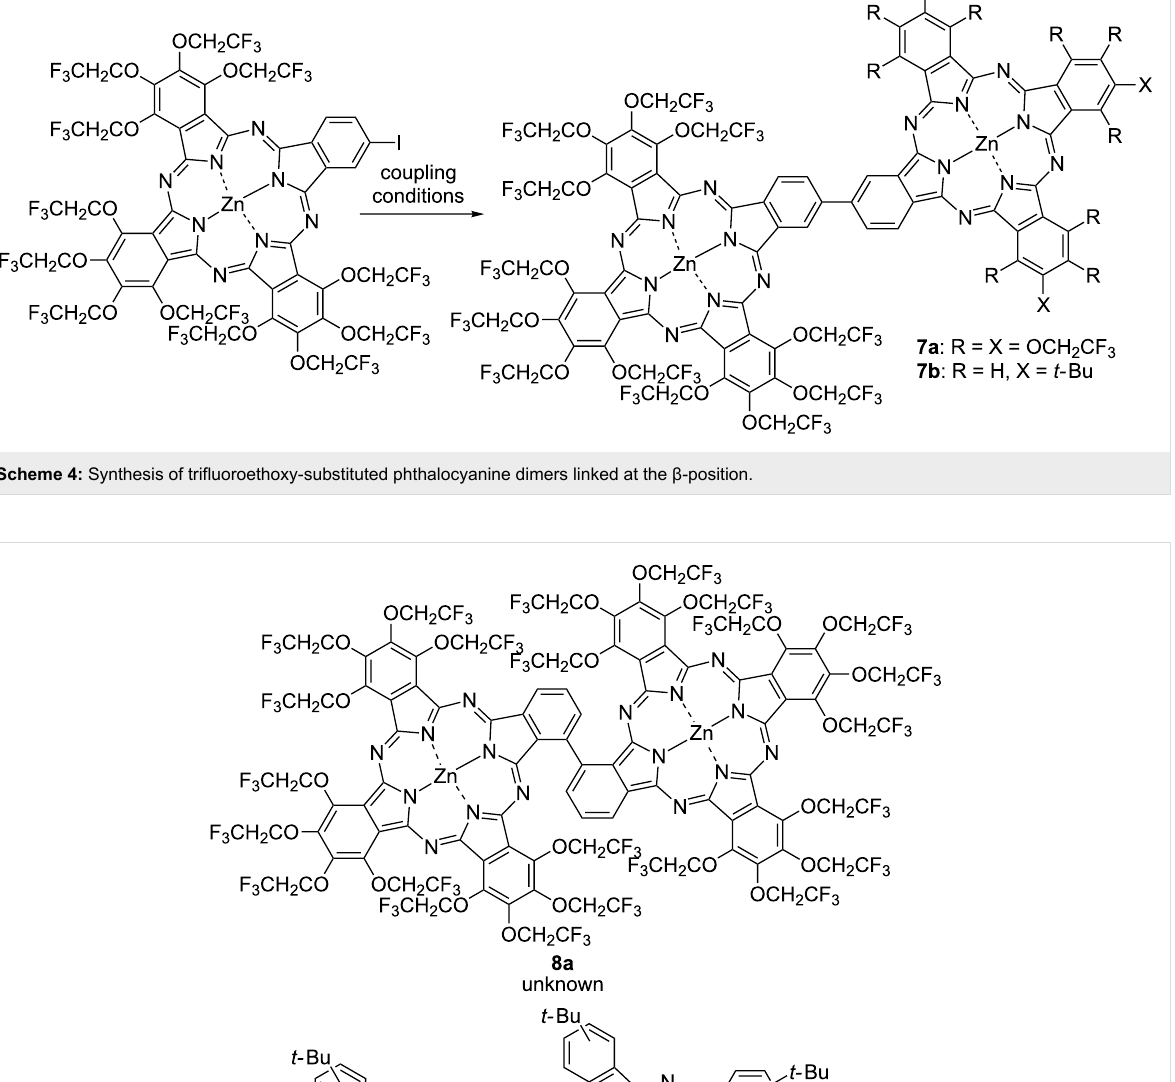
intramolecular electronic coupling is likely to be dependent on the overall planarity of the